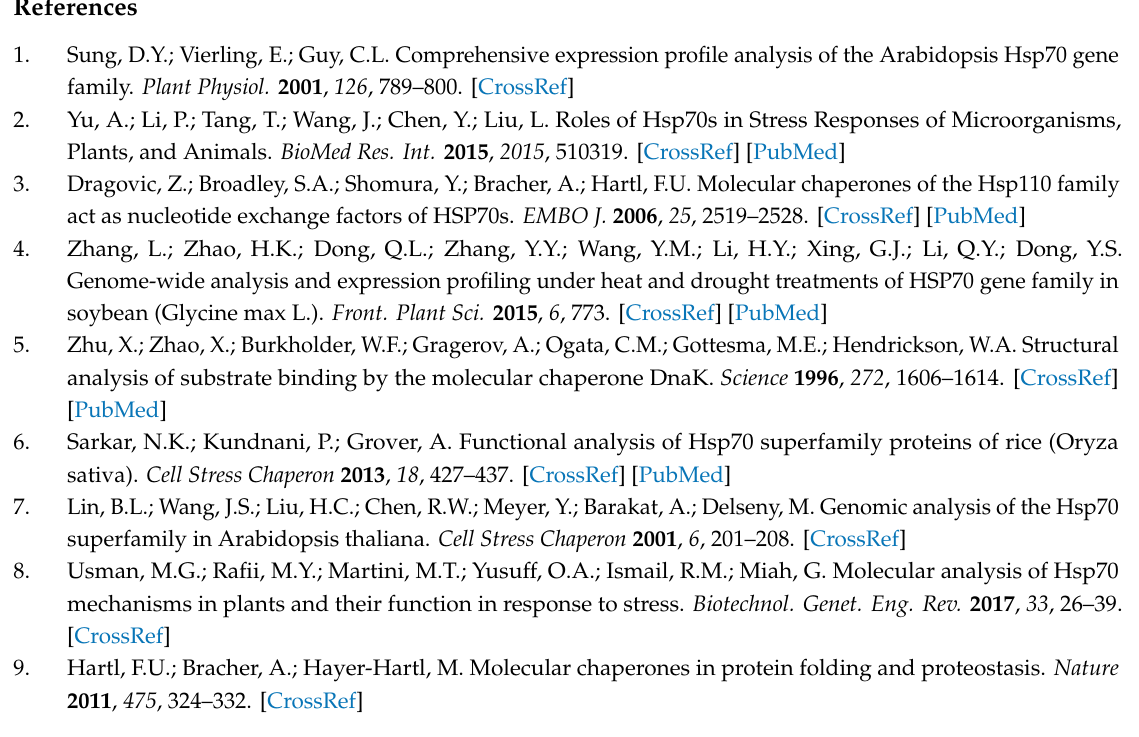
Table S1: Co-expression analysis of Arabidopsis HSP70S orthologous, obtained using the ATTED-II database, Table S2: Expression rate of MLOC_67581 and MLOC_50972 by qRT-PCR in barley Batin ì and Icarda 20 vs. Barley Nure, Table S3: List of selected genotypes of barley ( Hordeum vulgare ) utilized in this study, Table S4: List of primers used for qRT-PCR